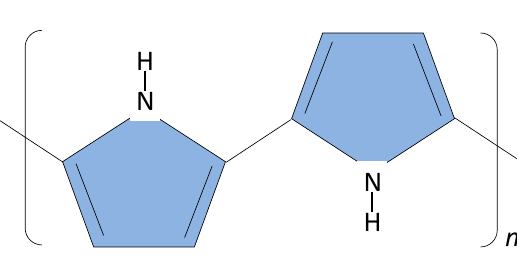
Figure 2. Structure of